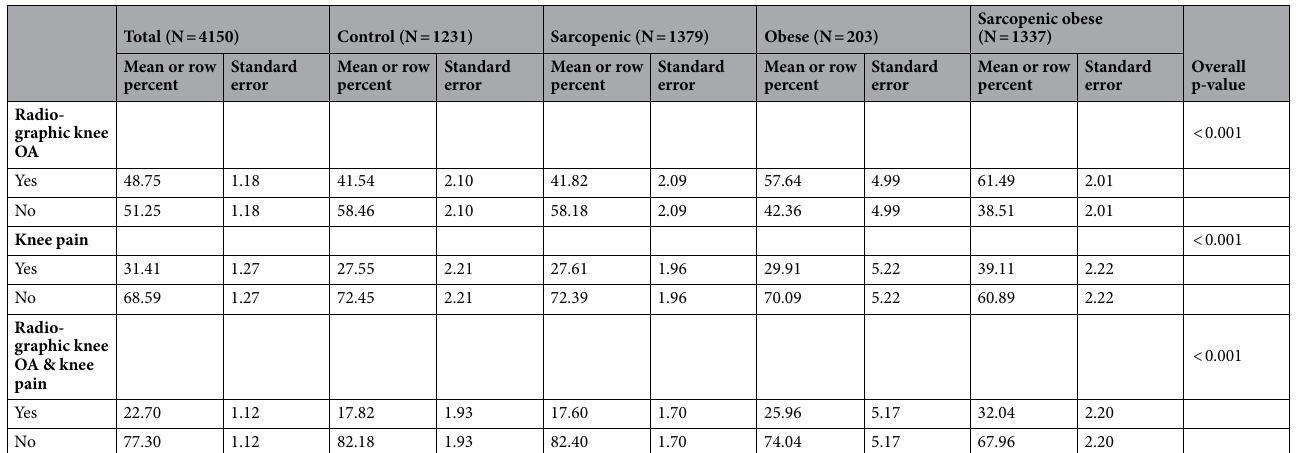
Table 2. Prevalence of radiographic knee OA, knee pain and both radiographic and knee pain in each group. Radiographic knee OA, Kellgren–Lawrence grade scale grade ≥ 2; Knee pain, knee pain for 30 days over